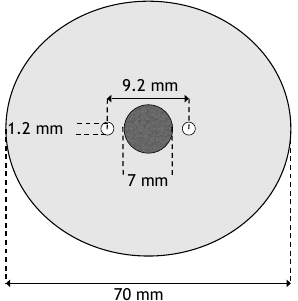
Figure 1. Schematic of the domain used for the